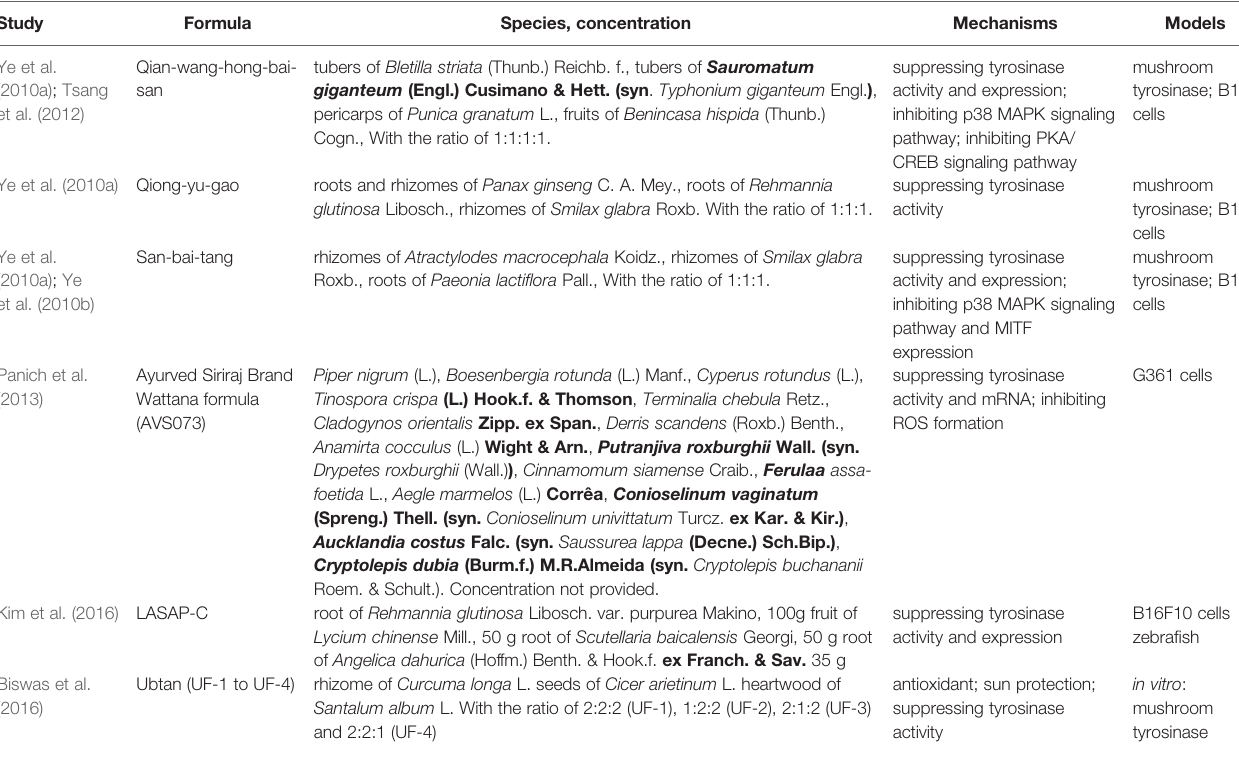
TABLE 1 | The information of Asian herbal